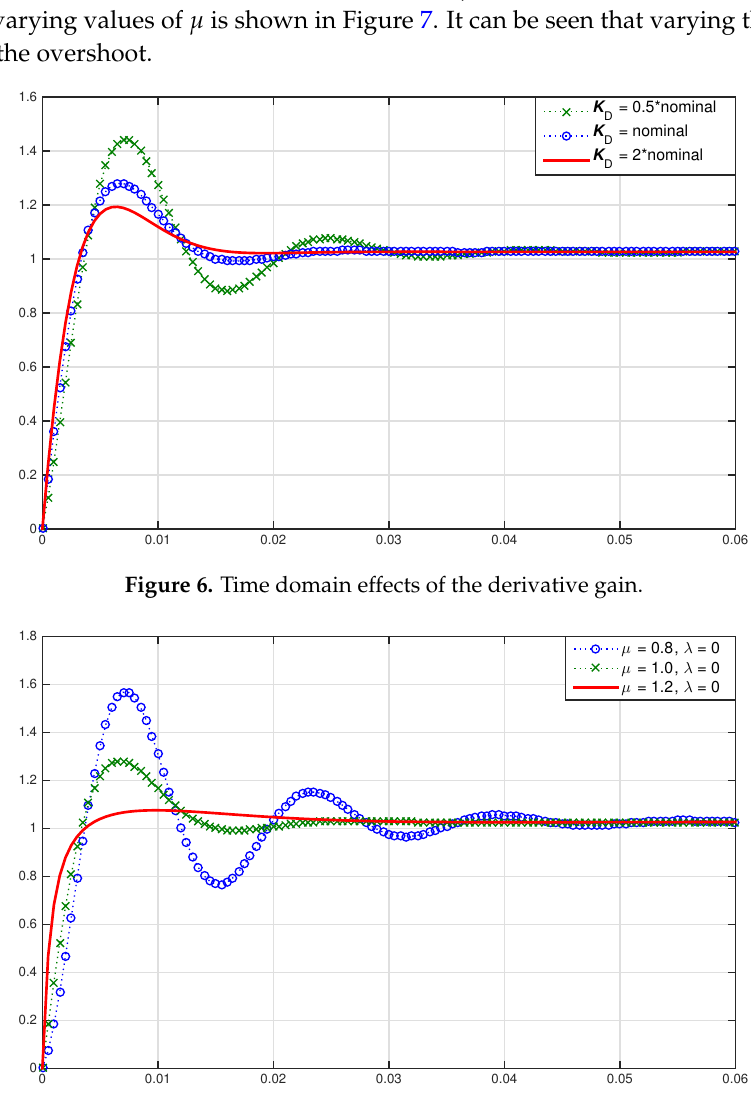
Figure 7. Time domain effects of the fractional derivative